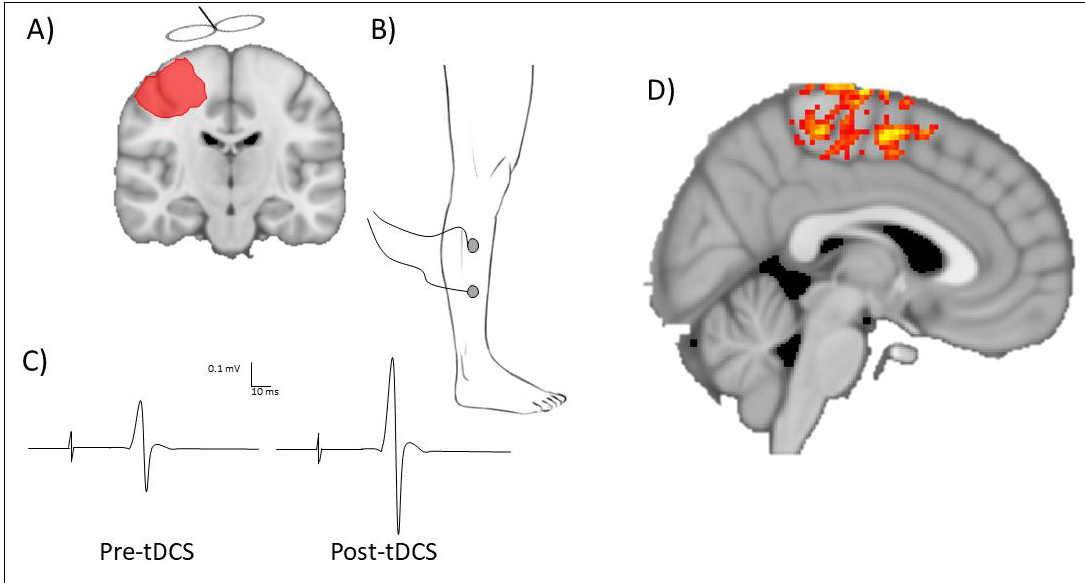
Figure 3. Techniques to quantify neurophysiological changes after lower limb transcranial direct current stimulation. One approach is to use transcranial direct current stimulation (tDCS) applied to the lower limb motor cortex ( A ) with surface electromyography recording motor-evoked potentials from a lower limb muscle on the paretic limb (for example, the tibialis anterior ( B )). An example motor-evoked potential can be seen in ( C ) which depicts the amplitude of the motor-evoked potential increasing after transcranial direct current stimulation. The magnitude of change in motor-evoked potential amplitude is a marker of corticospinal excitability and can be used to quantify tDCS response. An alternative technique is to use neuroimaging approaches such as functional magnetic resonance imaging. ( D ) An example of neural activity within the lower limb motor cortex. Changes in neural activation can be compared as a marker of physiological changes in the brain.